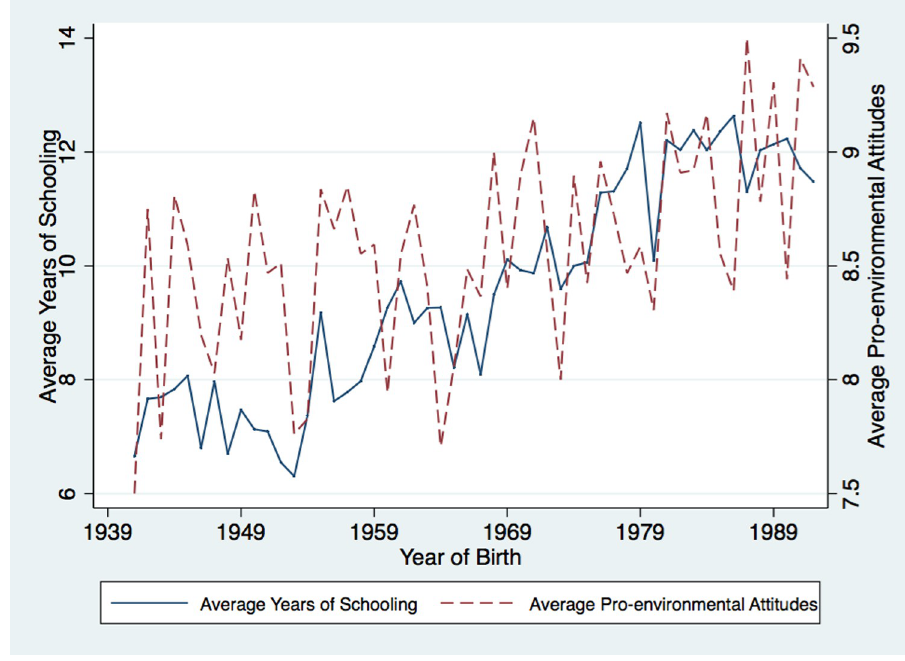
Fig 2. Average years of schooling and pro-environmental attitudes across year of birth. Note: This figure illustrates the relationships between education and pro-environmental attitudes and behaviors across year of birth. The solid line represents the average years of schooling and the dashed lines represent the average pro-environmental attitudes (2a) and behaviors (2b) respectively. Data source is CGSS 2010.